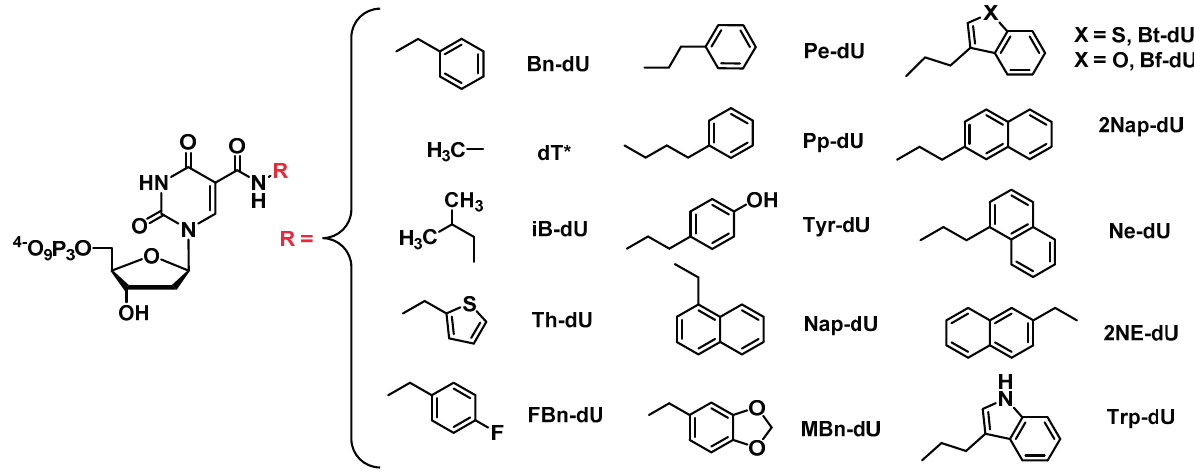
Figure 6. Examples of the 5-modified deoxyuridine triphosphates used as building blocks for the generation of SOMAmers [58,122,125,126]. R groups: Bn-dU: benzyldeoxyuridine; dT * :